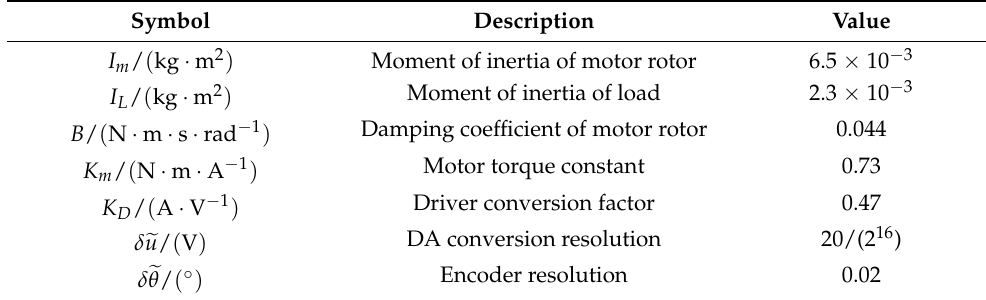
Table 1. Parameters of the experimental device.